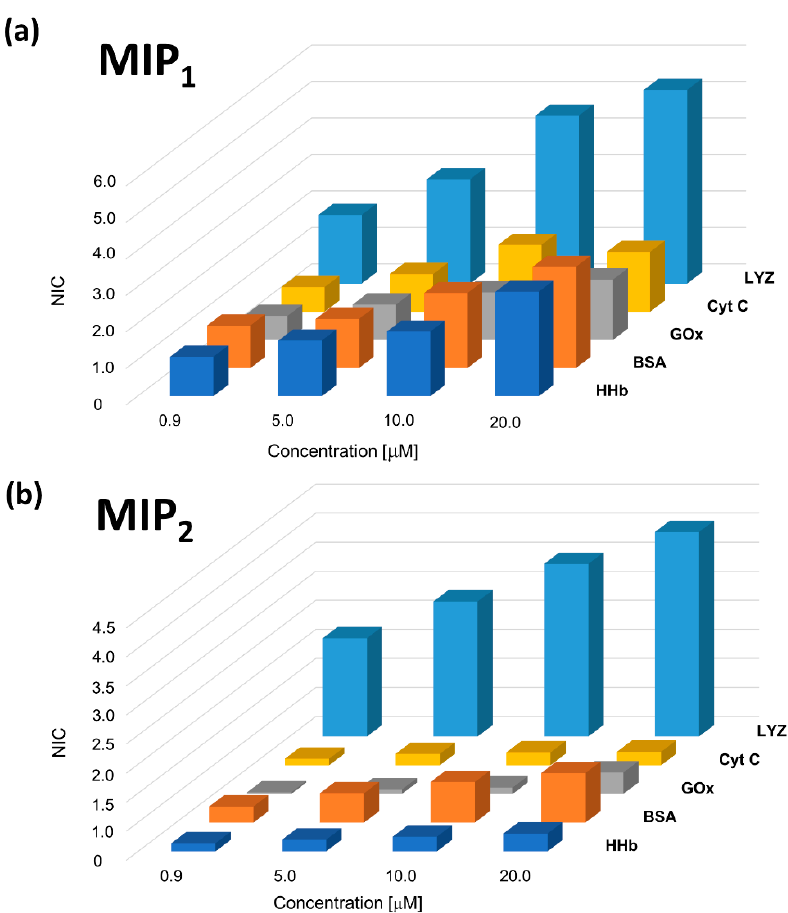
Figure 7. ( a ) MIP 1 and ( b ) MIP 2 sensors response to different interfering molecules.